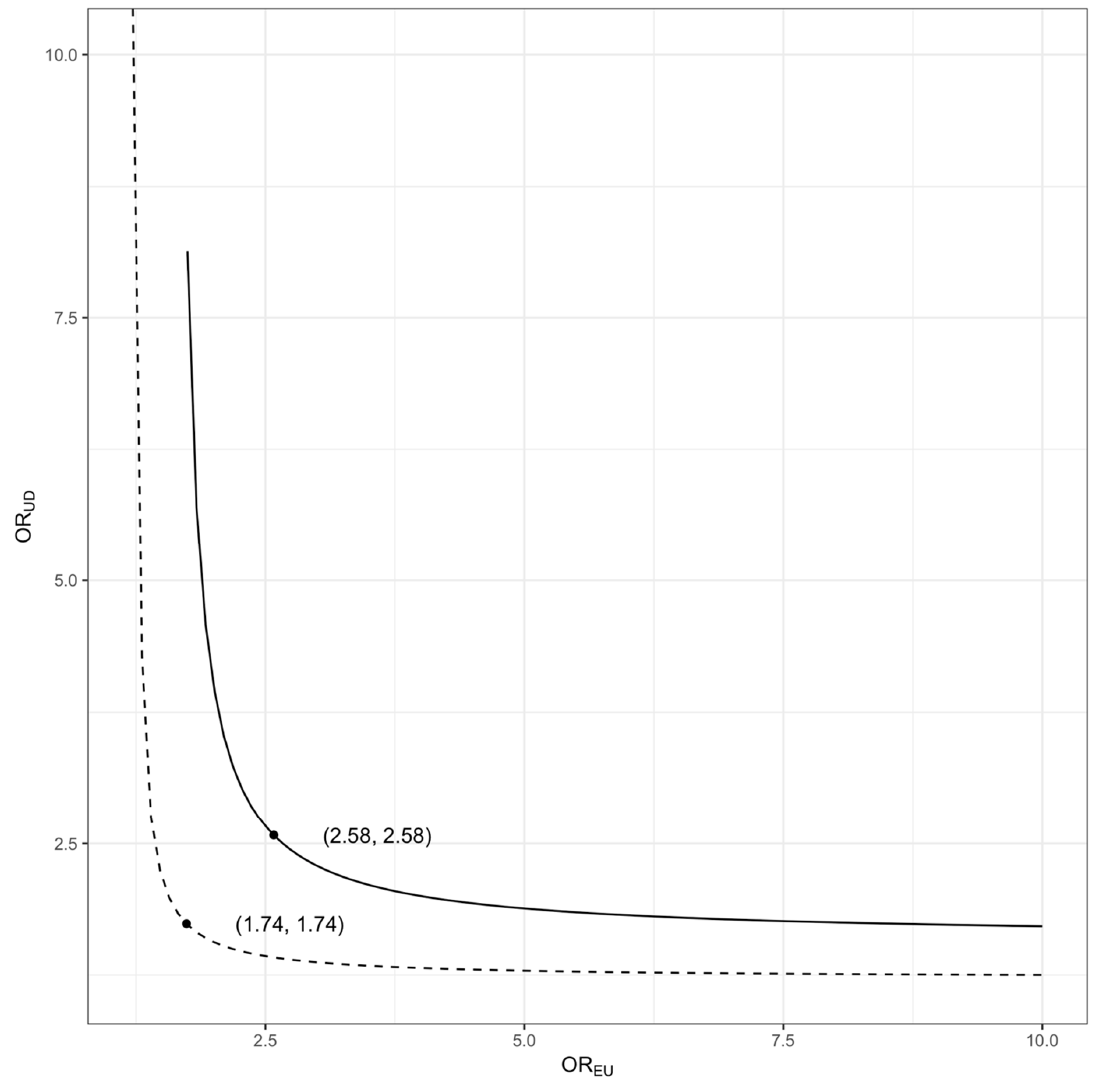
Figure A2. Sensitivity analysis for the association of education and low subjective well-being. The x-axis represents the association of the unmeasured confounder (U) and the exposure (education, E), whilst the y-axis represents the association of the unmeasured confounder (U) and the outcome (low subjective well-being, D). The area above the solid line is the joint values of the E-U and U-D associations that would be required to explain away the observed E-D association (RII = 1.60). The highlighted point on the line represents the strength of either of the E-U or U-D associations has to be bigger than that value in order to explain away the observed E-D association. The dashed line represents that of the lower bound of the 95% confidence interval (1.22). Overall, it means that in the case if either of the E-U or U-D associations has an odds ratio ≥ 1.74, the observed E-D association would be explained away to the null.